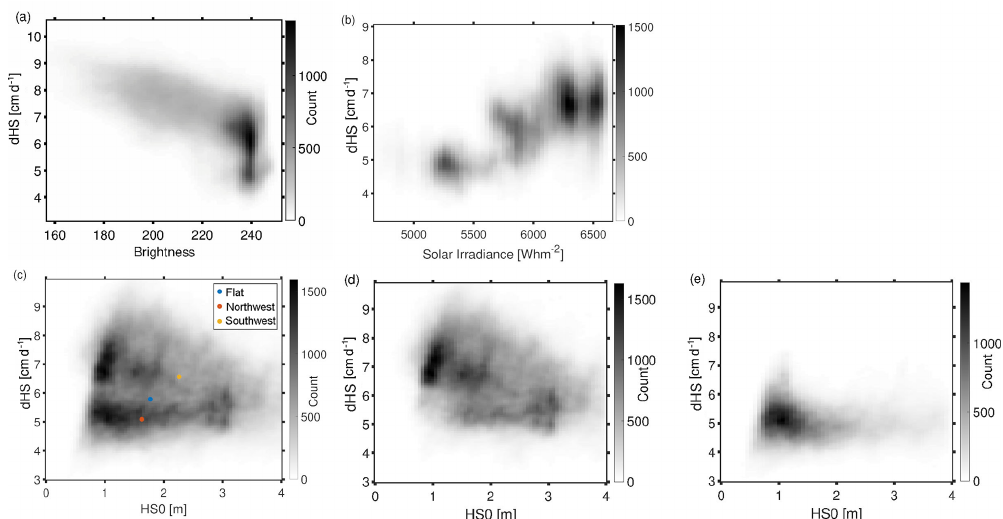
Figure 5. Scatter plots of (a) snow brightness and (b) solar irradiance versus differences in snow depth (dHS) for the northern subarea during P 1 . Darker tones indicate a higher density of points. In panel (b) only bright snow pixels are used (brightness > 230); scatter plots (c, d) show the dependence of dHS and HS 0 for the whole area with mean values (coloured points) for either side of the ridge and additionally flat pixels (c) , and only on the northwestern (d) and southeastern part of the ridge (e)